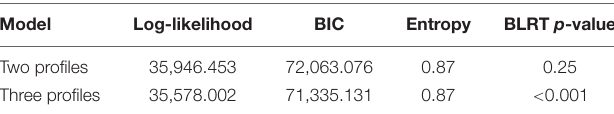
TABLE 4 | Latent profile models and fit indices.